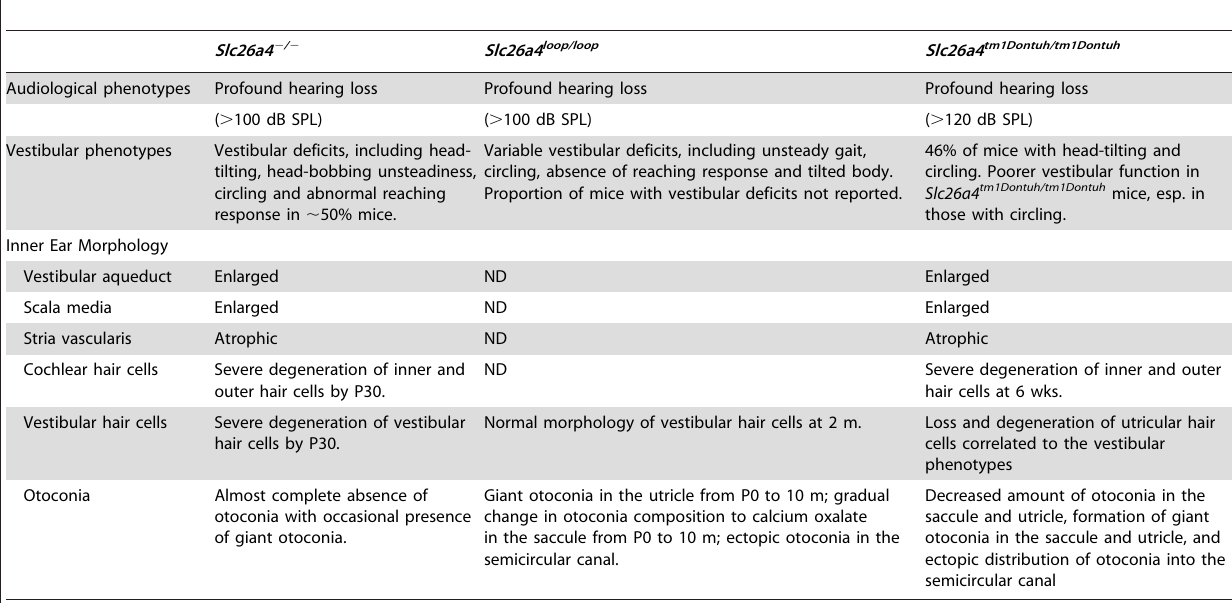
Table 3. Comparison of phenotypes among mouse strains segregating different slc26a4